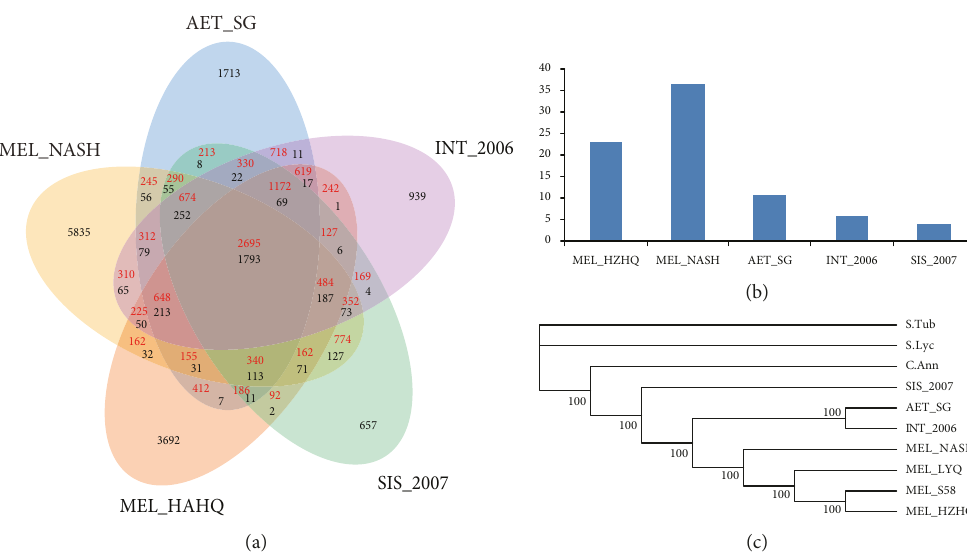
Figure 3: (a) Venn diagram exhibiting the comparison of orthologous gene sequences among the wild Solanum species S. sisymbriifolium (SIS_2007), S. aethiopicum (AET_SG), S. integrifolium (INT_2006), and S. melongena cultivar HZHQ (MEL_HZHQ) and Nakate- Shinkuro (MEL_NASH) transcriptome. The number of common or speci fi c genes is list in the circle. The shared genes among fi ve species are categorized as single copy (1 :1, red letters) and multicopy (N :N; black letters). (b) The histogram showing the ratio of species-speci fi c genes. (c) The phylogenetic tree constructed using OrthoMCL based on the sequences of orthologous genes in the six eggplant samples and other Solanaceae family species ( C. annuum , S. lycopersicum , and S. tuberosum ). All of the nodes have 100% bootstrap support